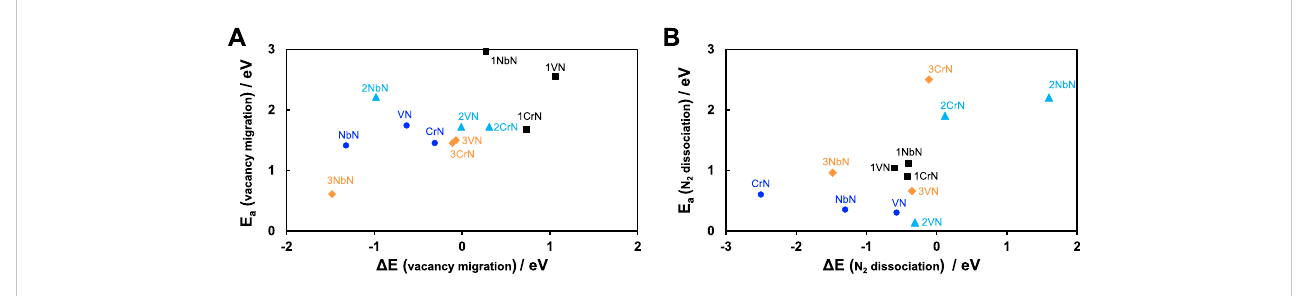
FIGURE 4 (A) Energy differences, Δ E fi rst subsurface layer of a nitride and the associated (vacancy migration) , of presence of a N-vacancy at the surface layer and in the activation energy of N-vacancy migration, E a (vacancy migration) . (B) Energy differences, Δ E (N , of nitrogen molecule dissociation on a N-vacancy at the 2 dissociation) surface layer and the associated activation energy, E a (N . The larger the E a is, the slower would be the rate of the reaction according to k = ν exp 2 dissociation) ( − E a /k B T), where ν is the normal attempt frequency as the prefactor, E a is the activation energy (eV) of the reaction, k B is the Boltzmann constant and T is the temperature. Since ZrN overlayers do not result in ammonia formation, these analyses have not included ZrN